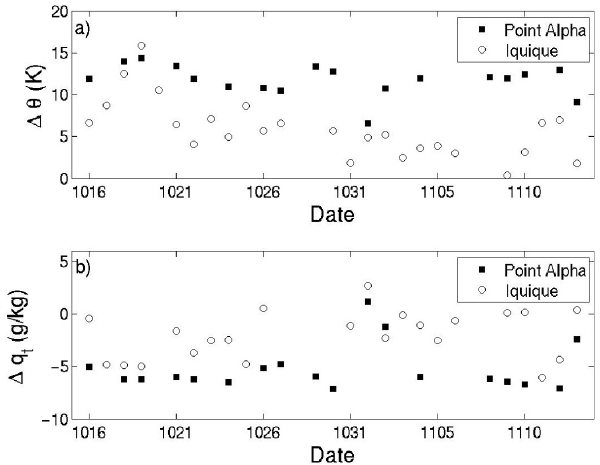
Fig. 11. (a) 1θ (K); (b) 1q t (gkg − 1 ). The solid squares represent the values at Point Alpha measured by the aircraft, and the open circles donate the values at Iquique measured by the radiosonde system.